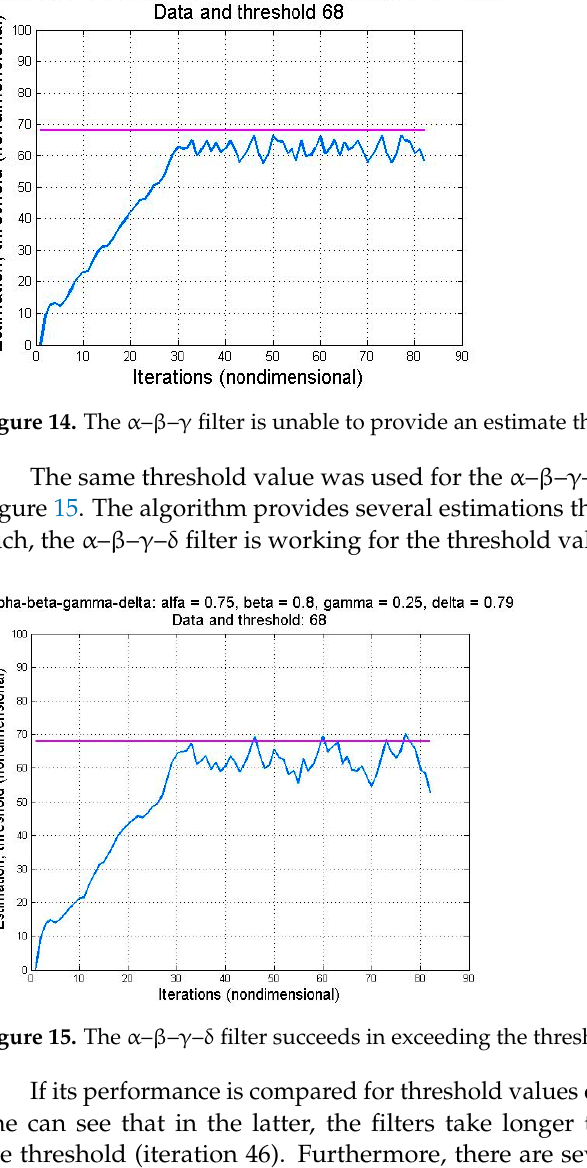
Figure 15. The α – β – γ – δ filter succeeds in exceeding the threshold value of 68.